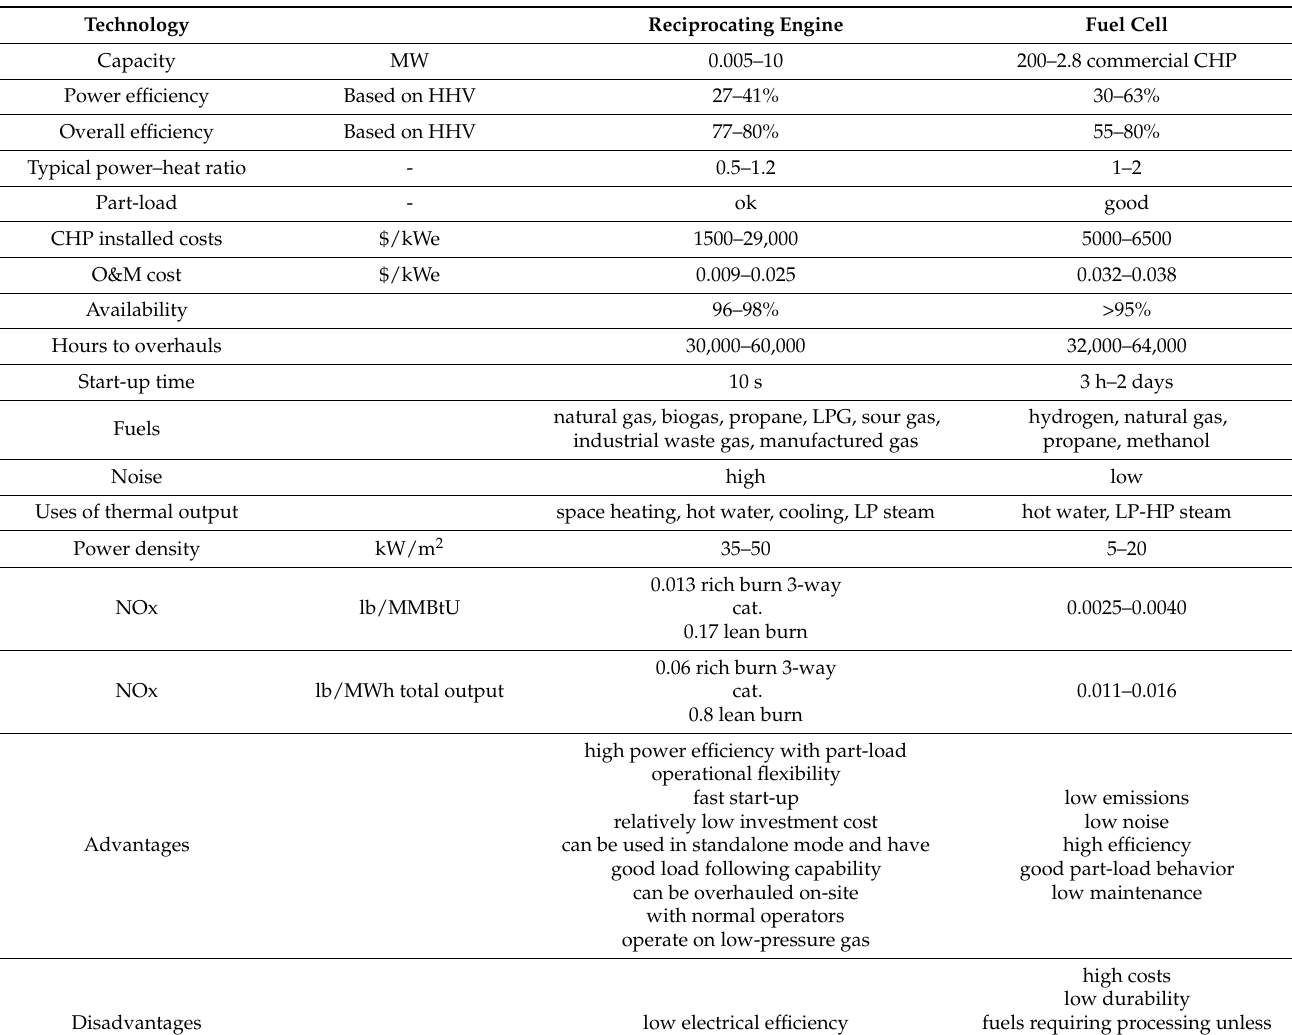
Table 4. Comparison of CHP technologies: sizing, cost, and performance parameters—part 2